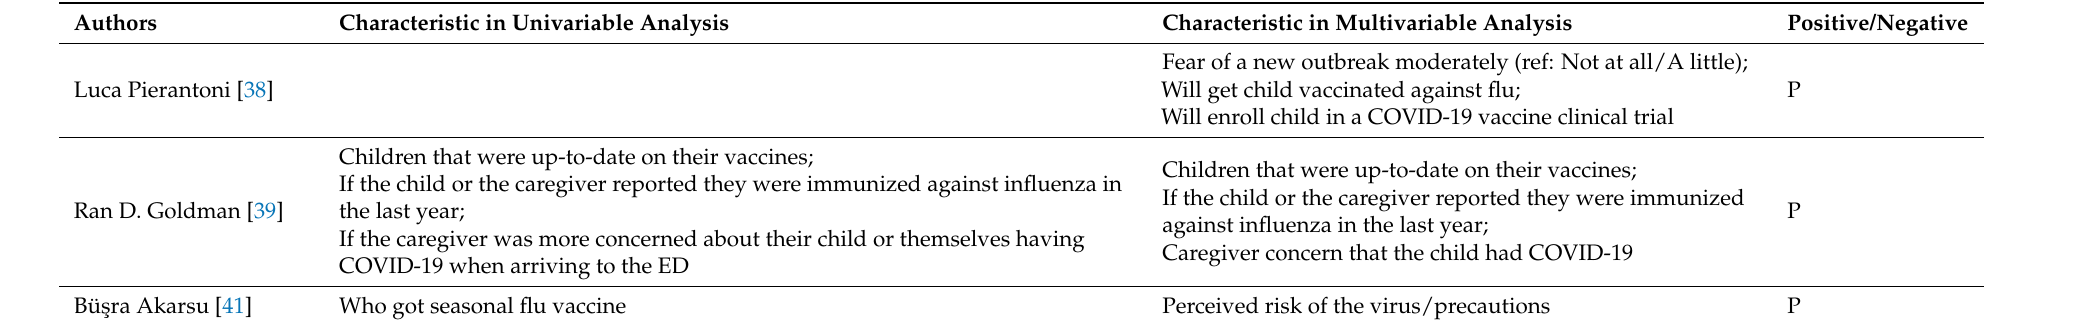
Table 4. Subjective factors influencing parents’ decision to vaccinate children against